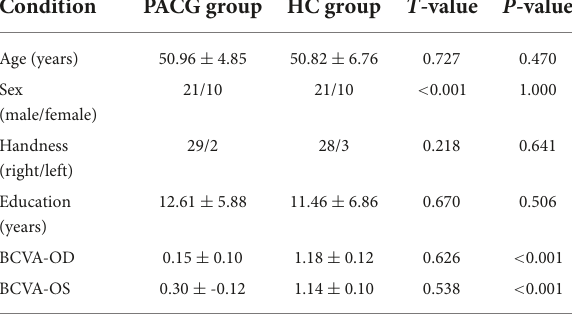
TABLE 1 Demographic and clinical measurements between patients with PACG and